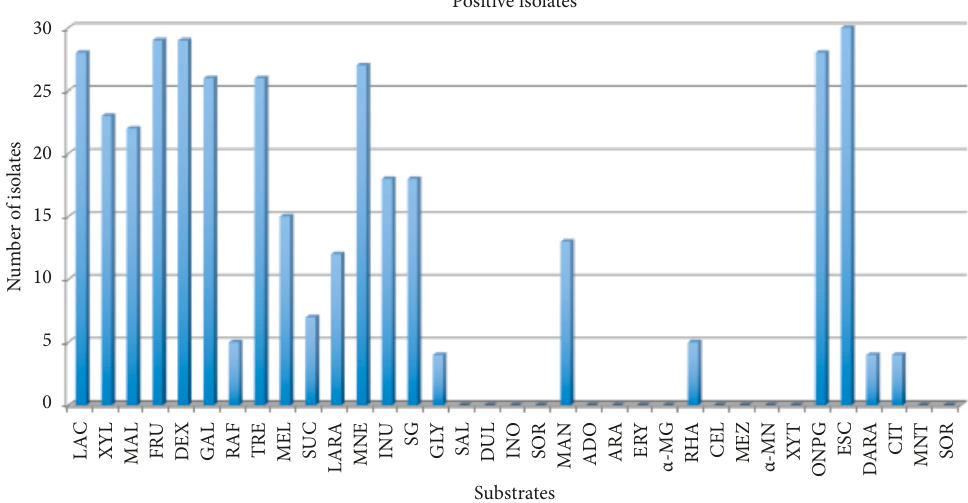
Figure 1: Metabolic activity of all E. coli blood isolates.